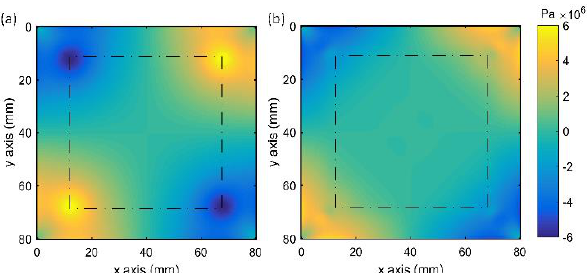
Figure 6. Mean stress distributions in the central cross-sections of the gain slabs ( a ) without and ( b ) with the absorbing cladding layer. The dotted lines indicate the laser beam area.